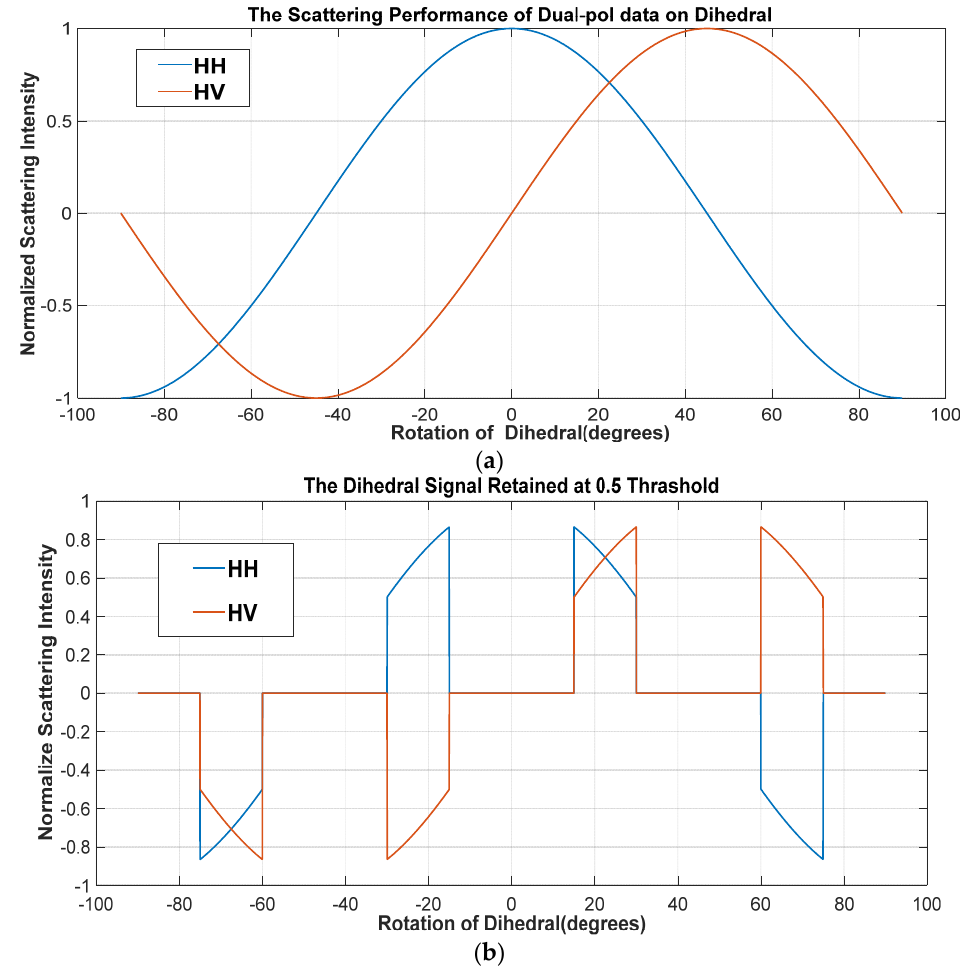
Figure 1. Simulation schematic diagram of dual-pol data on a perfect dihedral: ( a ) The perfect dihedral scattering responses of the HH and HV polarization channels; ( b ) 0.5 is set as a threshold, the part where absolute amplitudes of both HH and HV are above the threshold is retained.